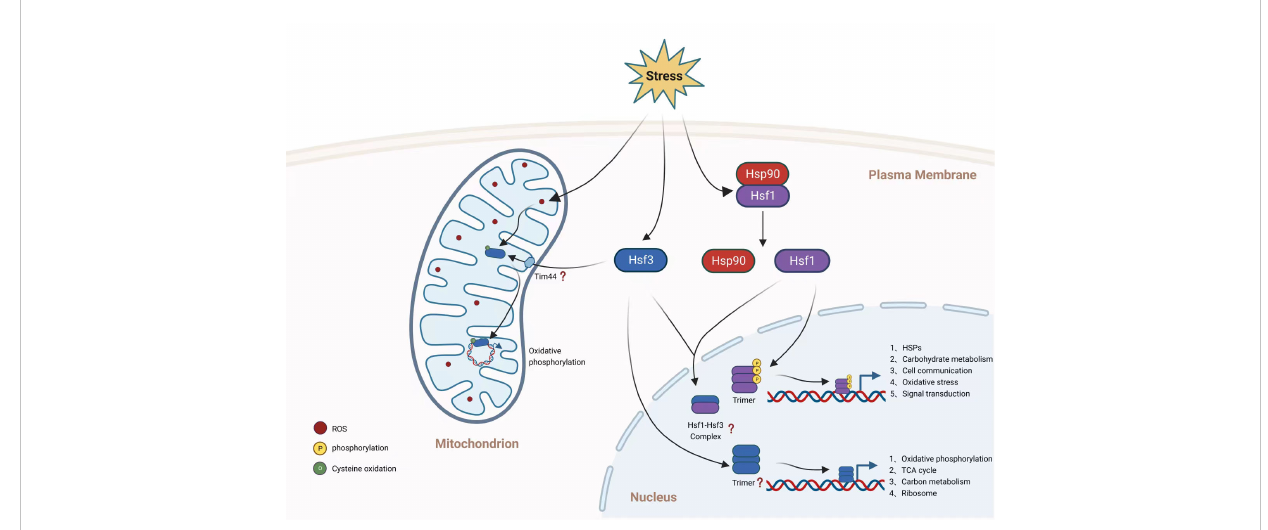
FIGURE 2 Hsf transcription regulation of C. neoformans . Hsf1 and Hsf3 participate in transcriptional regulation of gene expression, however the role of Hsf2 in C. neoformans is unknown. While Hsf1 and Hsf3 are transcription factors con fi ned to the nucleus, Hsf3 is also translocated to the mitochondrion. As investigated in other organisms, Hsf1 in C. neoformans is likely repressed by Hsp90 under normal conditions and then translocated to the nucleus, where it is phosphorylated. The activated Hsf1 is subsequently trimerized to bind to gene promoter regions. Hsf1 of C. neoformans regulates the gene expression of canonical and noncanonical genes involved in glucose metabolism, cell communication, oxidative stress, and signal transduction. It is unknown if C. neoformans Hsf3 trimerizes in response to stimulation or if an Hsf1-Hsf3 complex is produced. Hsf3 in the nucleus of C. neoformans regulates the expression of genes involved in the TCA cycle, the electron transport chain, and the ribosome. ROS levels regulate the activity of mitochondrial Hsf3, which binds to the mitochondrial genome to promote the production of genes encoding the electron transport chain. This fi gure was created with